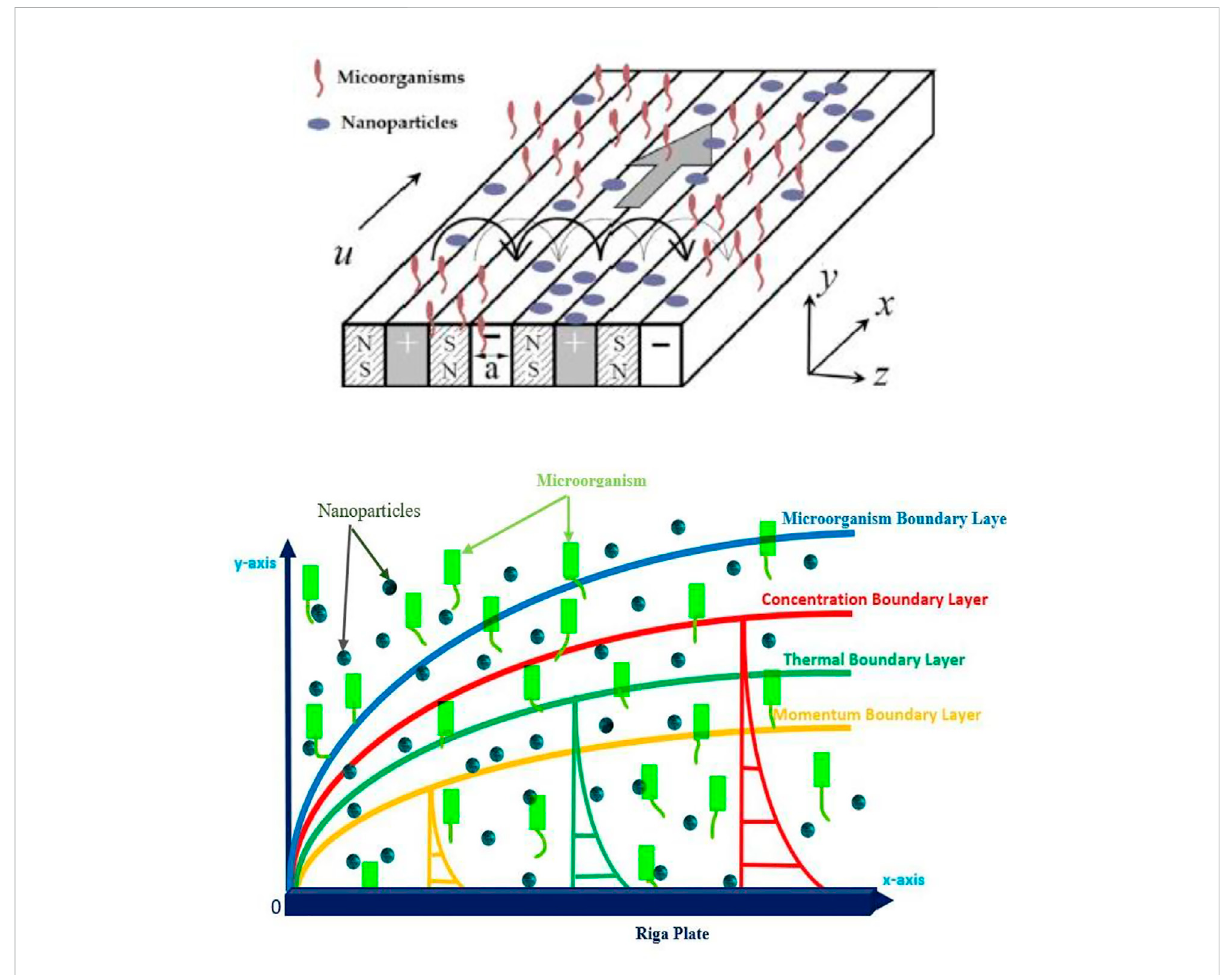
FIGURE 1 Physical sketch of the fl ow